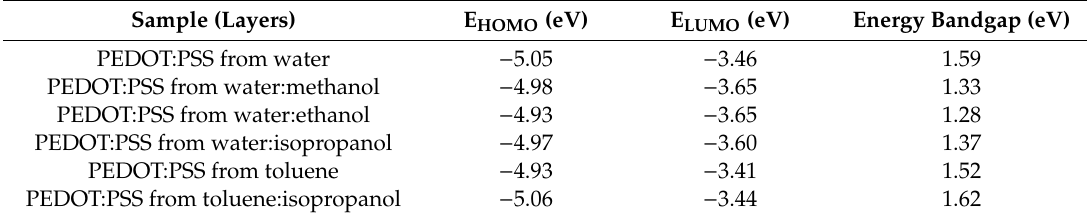
Table 4. Summary of selected electrochemical values for layers prepared from aqueous and toluene based solutions of PEDOT:PSS with and without of alcohol.